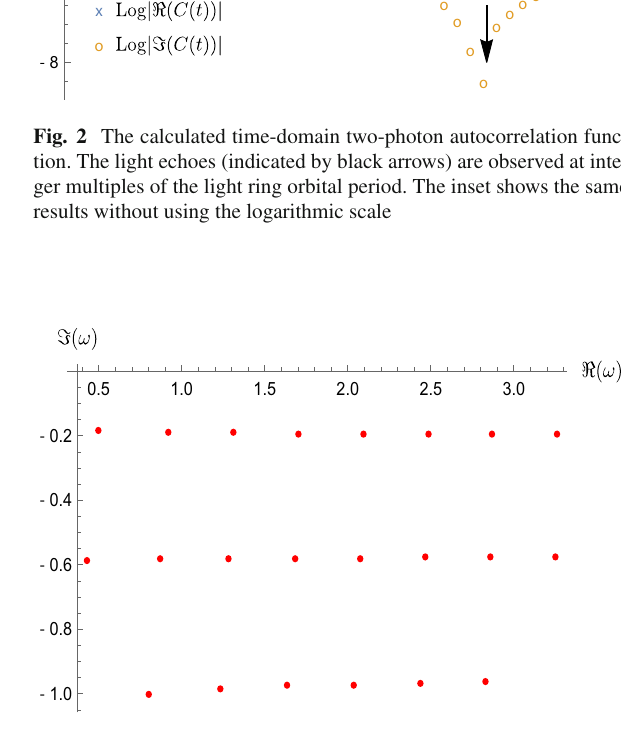
Fig. 3 The quasinormal mode spectrum of electromagnetic perturba- tions for different overtone numbers n and angular momenta (cid:2) . For the electromagnetic perturbations in the Schwarzschild black hole, an extensive study was performed in [22]